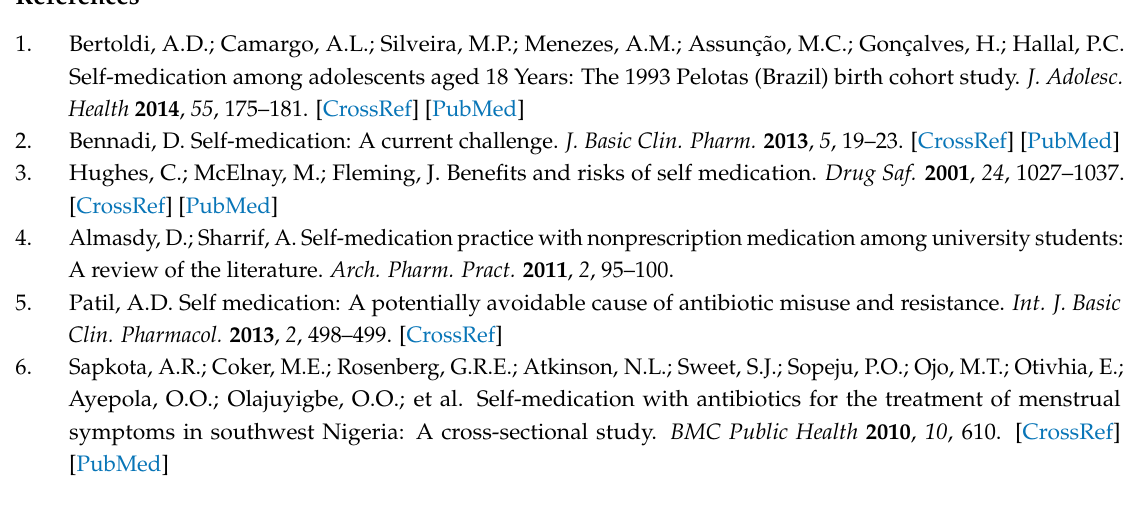
Table S1: Variable names and